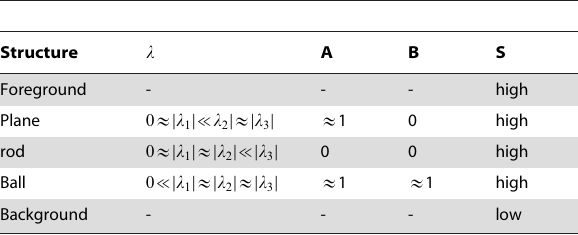
Table 1. Geometric structure classification based on eigen- system.